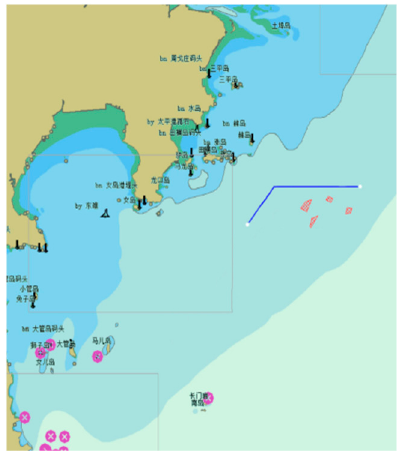
Figure 13. Results of path planning in electronic chart.